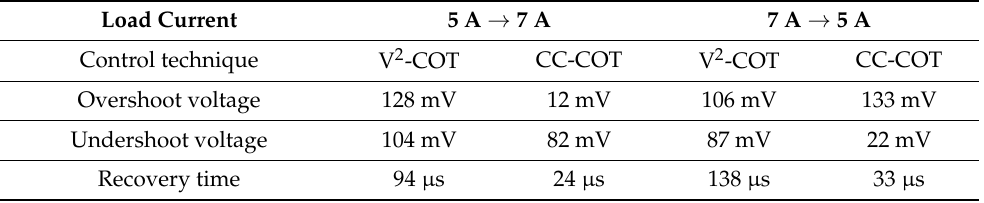
Figure 4. Transient state simulation results for two COT controls with output capacitor ESR r = 10 m Ω , where the load current is switched to 7 A from 5 A and then back to 5 A. ( a ) V 2 -COT control and ( b ) CC-COT control. Table 2. Transient performance comparison for V 2 -COT control and CC-COT control with the small output capacitor